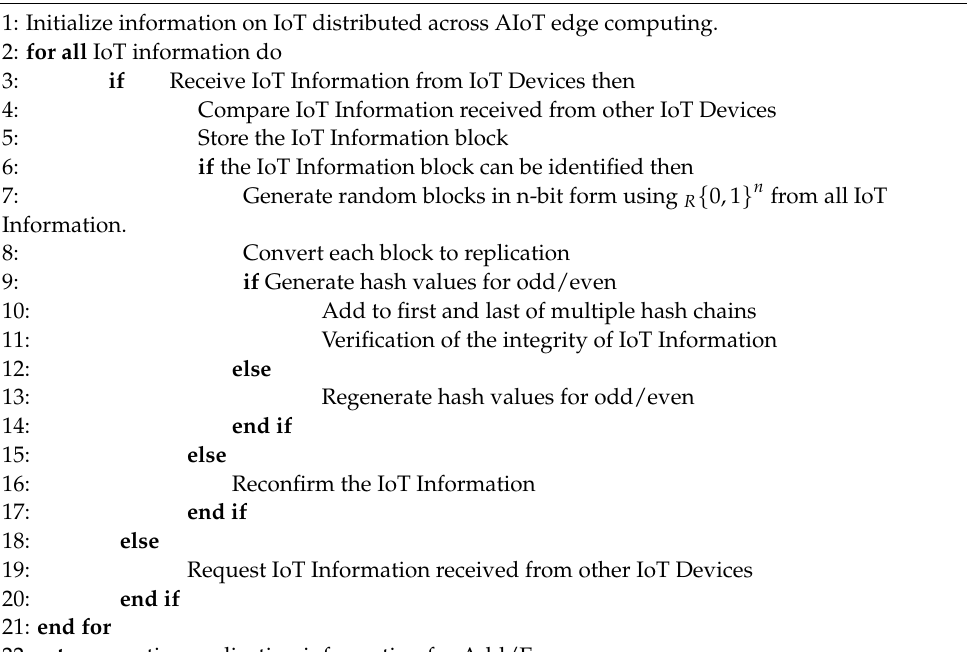
Algorithm 1. IoT information generation algorithm based on